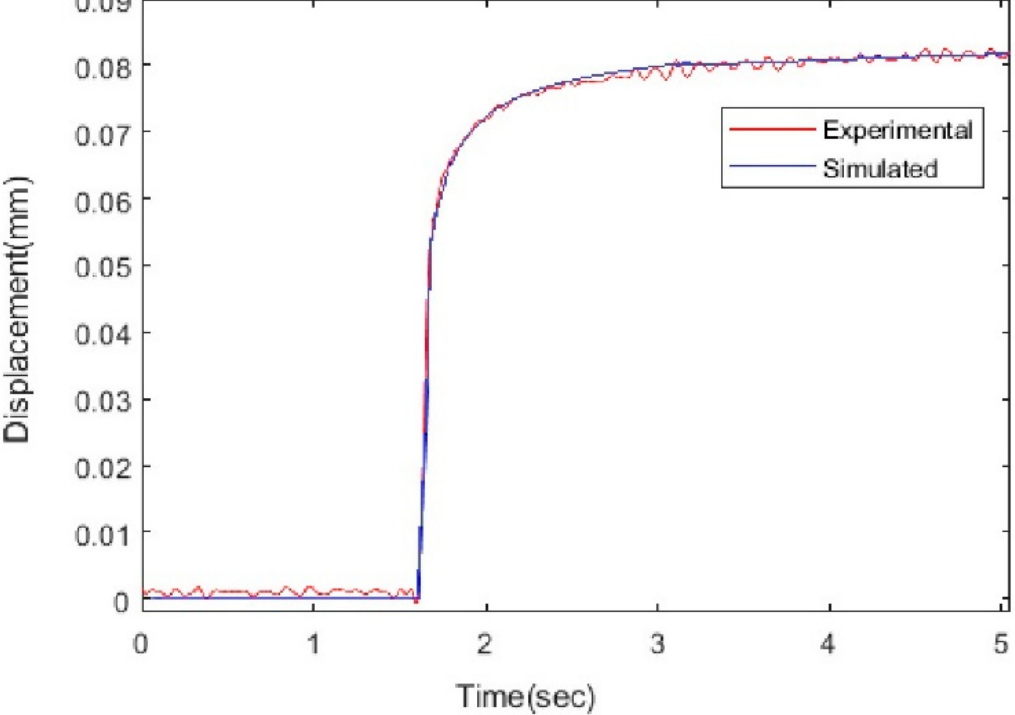
Figure 24. Step response of non-conductive material with VCA.